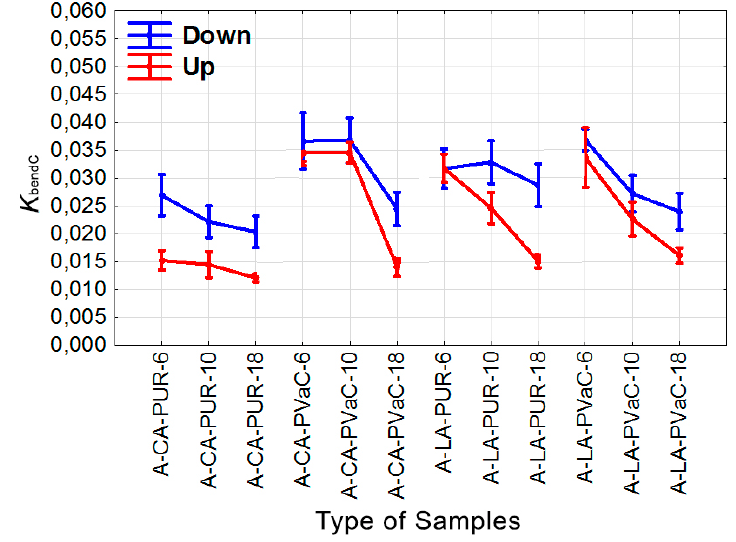
Figure 4. K bendC in case of aspen.